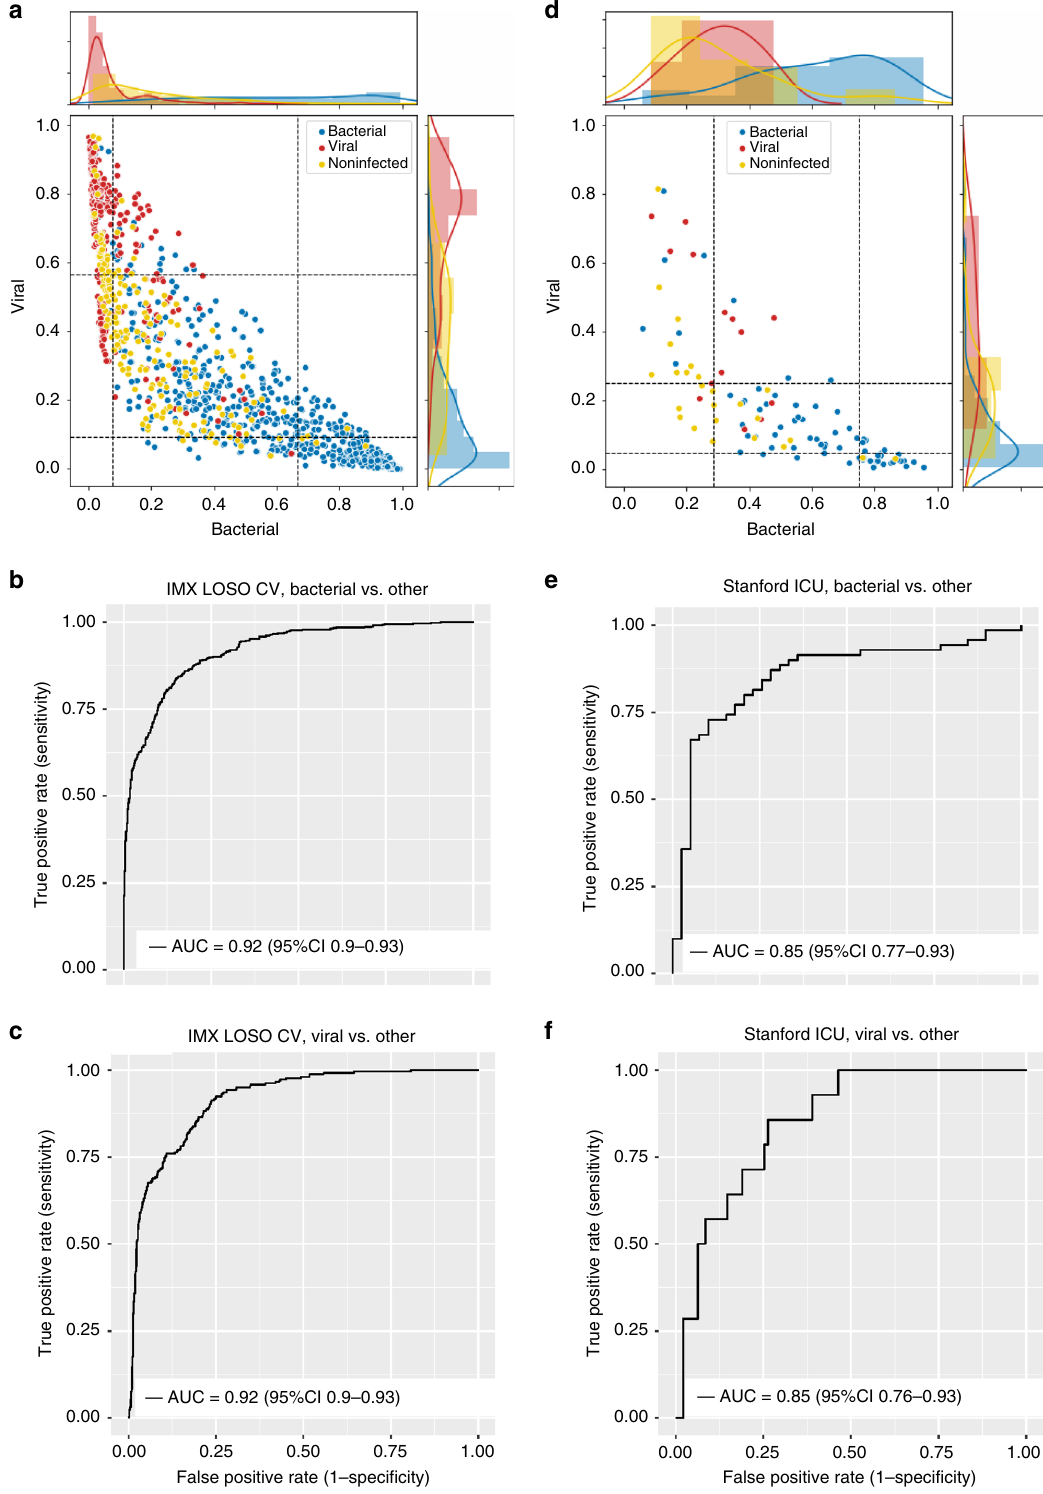
Fig. 2 Distribution of IMX-BVN-1 predicted bacterial and viral probabilities in IMX LOSO and Stanford ICU validation. a , d Each dot in the scatter plot corresponds to a sample ( x -axis: bacterial predicted probability, y-axis: viral predicted probability). The histogram/density plot above the scatter plot shows bacterial probabilities while the plot to the right of the scatter plot shows viral probabilities. The dotted lines indicate cutoffs for the lower and upper quartiles. b , c , e , f Receiver-operating characteristic (ROC) curves for IMX-BVN-1 in IMX ( b , c ) and Stanford ICU ( e , f ) data for bacterial-vs-other ( b , e ) and viral-vs-other ( c , f ) comparisons. AUC, area under the ROC